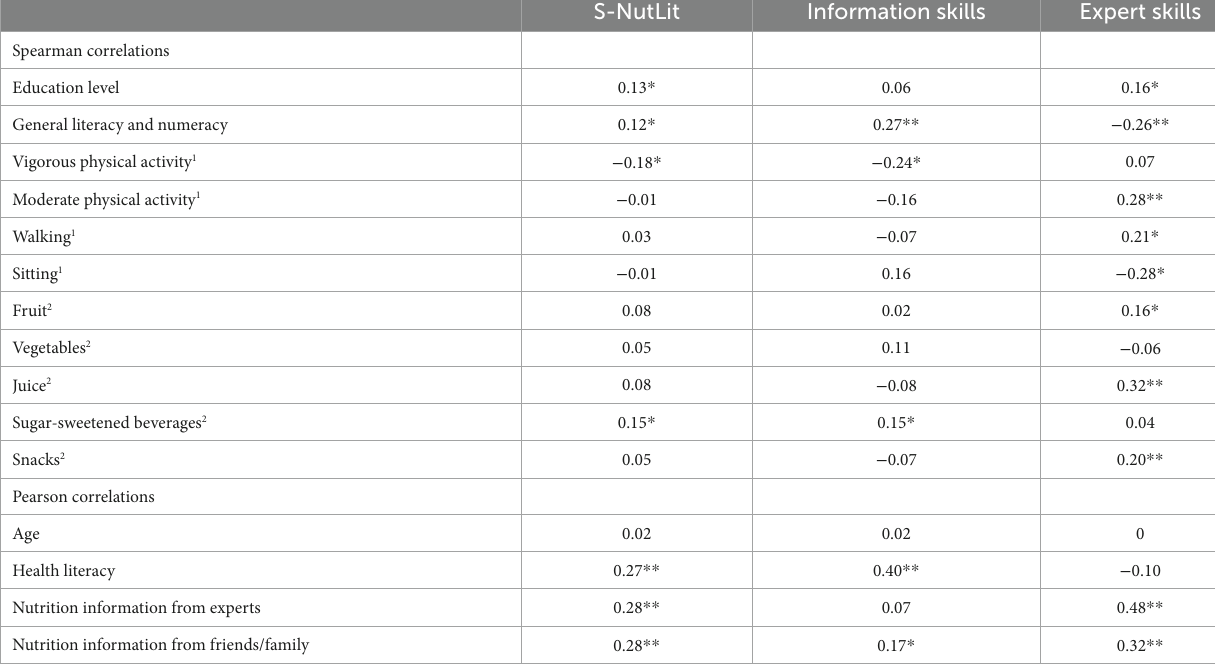
TABLE 3 Associations between S-NutLit, subscales and related